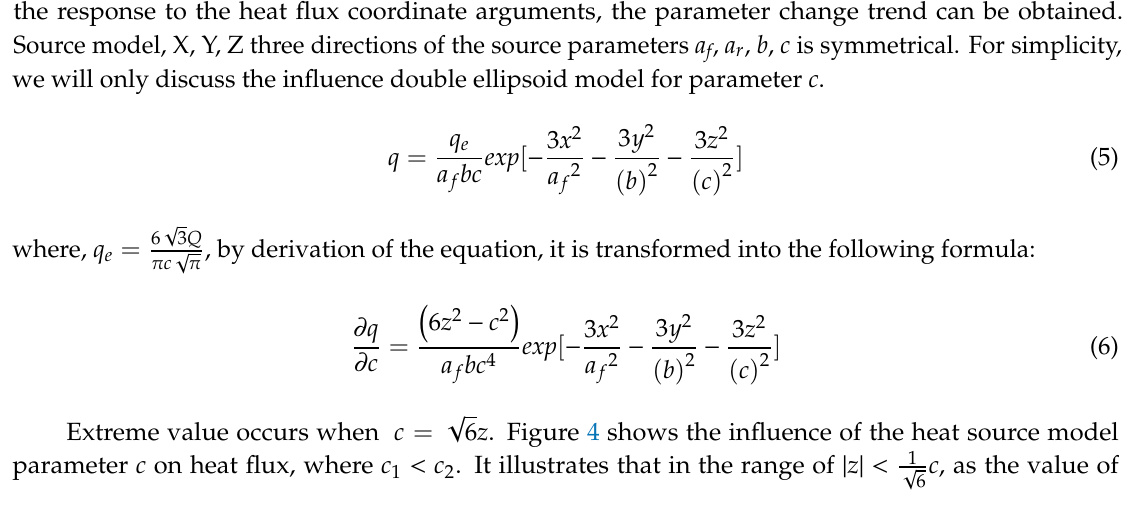
Figure 3. Conversion of coordinates.